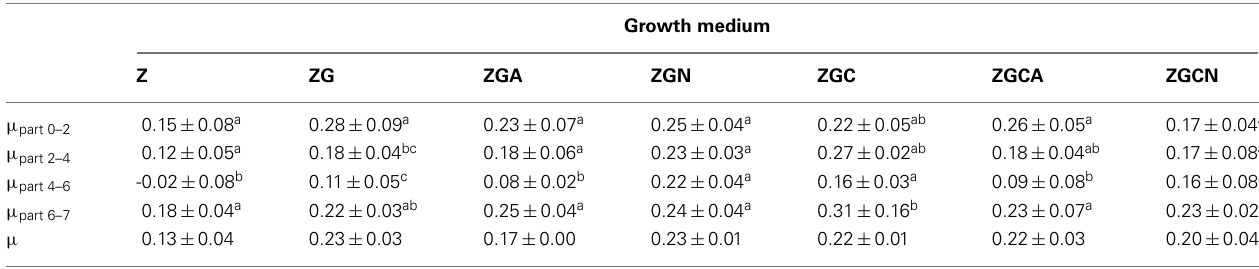
Table 2 | µ part and µ (day − 1 ; mean ± SD, n = 6) of Chlorella mirabilis in various compositions of growth medium (seeTable 1 for growth media explanations) under in-door conditions (irradiance of 75 µ molm − 2 s − 1 and temperature of 15˚C).